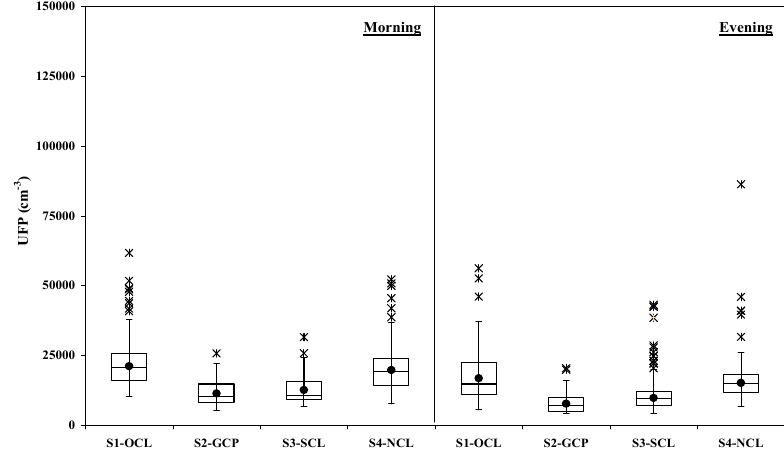
Figure 5. Box-plots of 1-min concentration data for UFP in the warm season (mean values: dots; min-max range: whiskers: median and interquartile range: boxes).